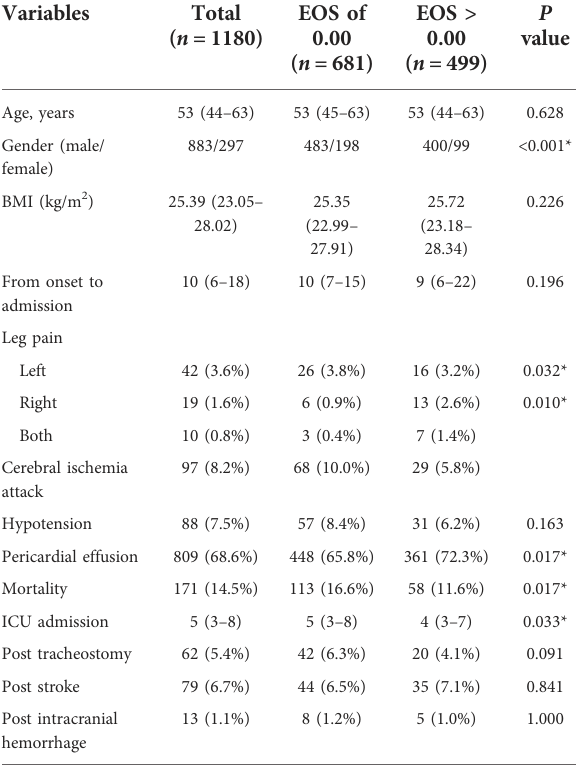
TABLE 5 Predictors of mortality after AAAD surgery in multivariable logistic regression.